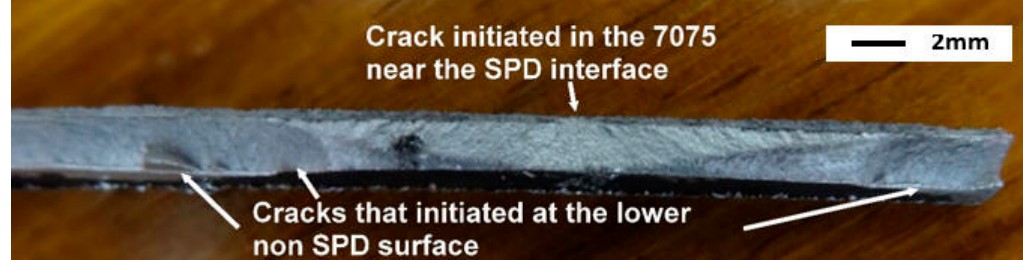
Figure 19. ( a ) The unrepaired simulated corrosion test specimen; ( b ) the repaired specimen.